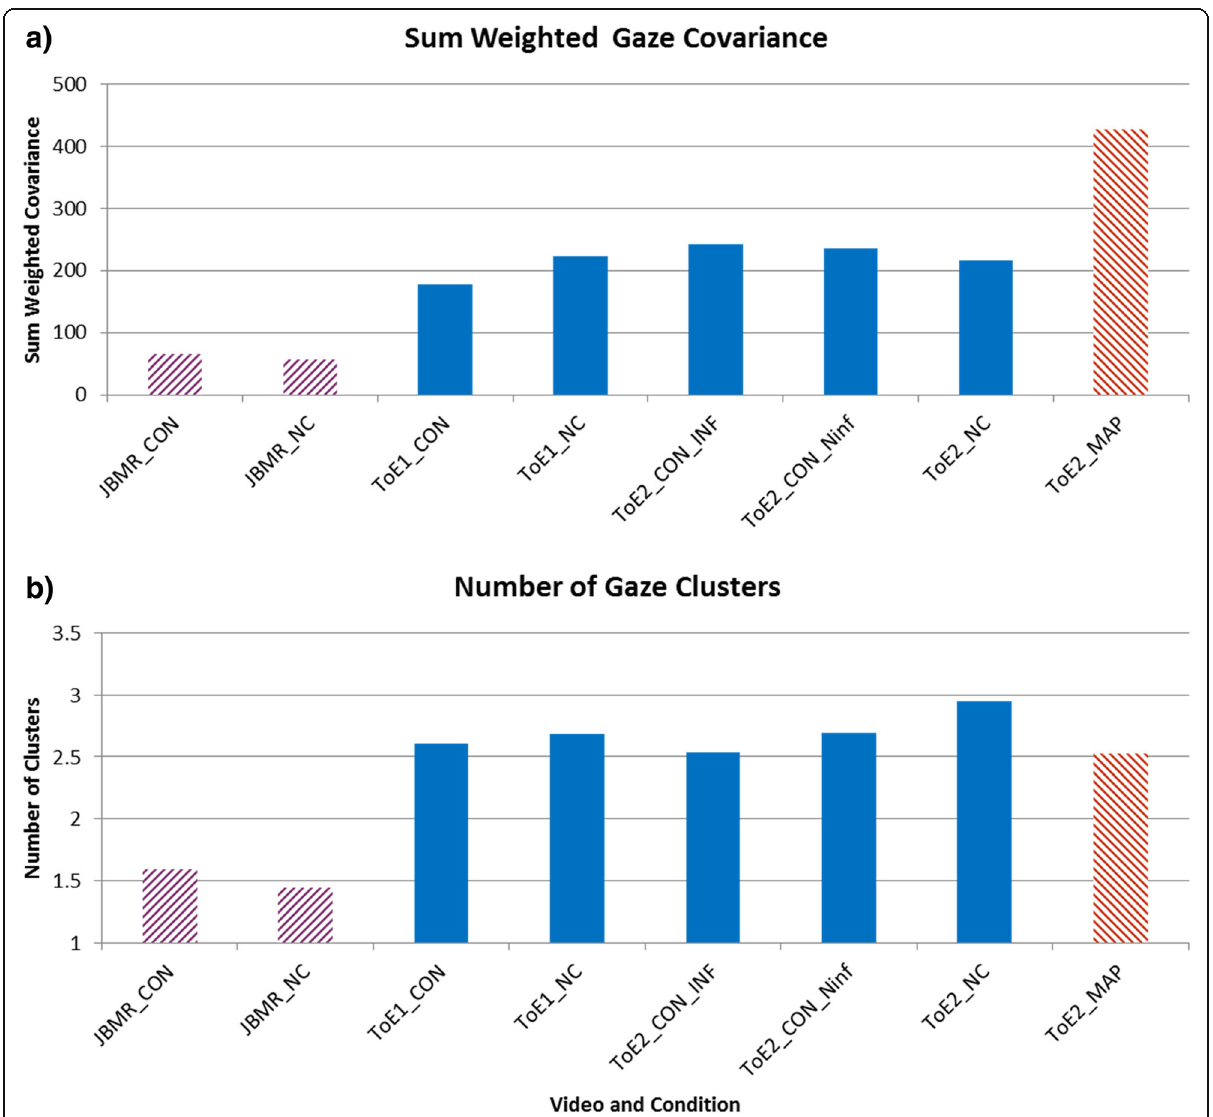
Fig. 8 a The average sum weighted gaze covariance for all eye-tracking conditions in the James Bond film Moonraker (Loschky et al., 2015) and Touch of Evil studies. The purple bars are for the Moonraker study, the blue bars are for the Touch of Evil comprehension conditions, and the red bar is for the Touch of Evil map task. b The average number of gaze clusters for the same experiments. JBMR_CON , James Bond Moonraker Context condition; JBMR_NC , James Bond Moonraker No-context condition; ToE1_CON , Touch of Evil experiment 1 Context condition; ToE1_NC , Touch of Evil experiment 1 No-context condition; ToE2_CON_INF , Touch of Evil experiment 2 Context+Inference; ToE2_CON_Ninf , Touch of Evil experiment 2